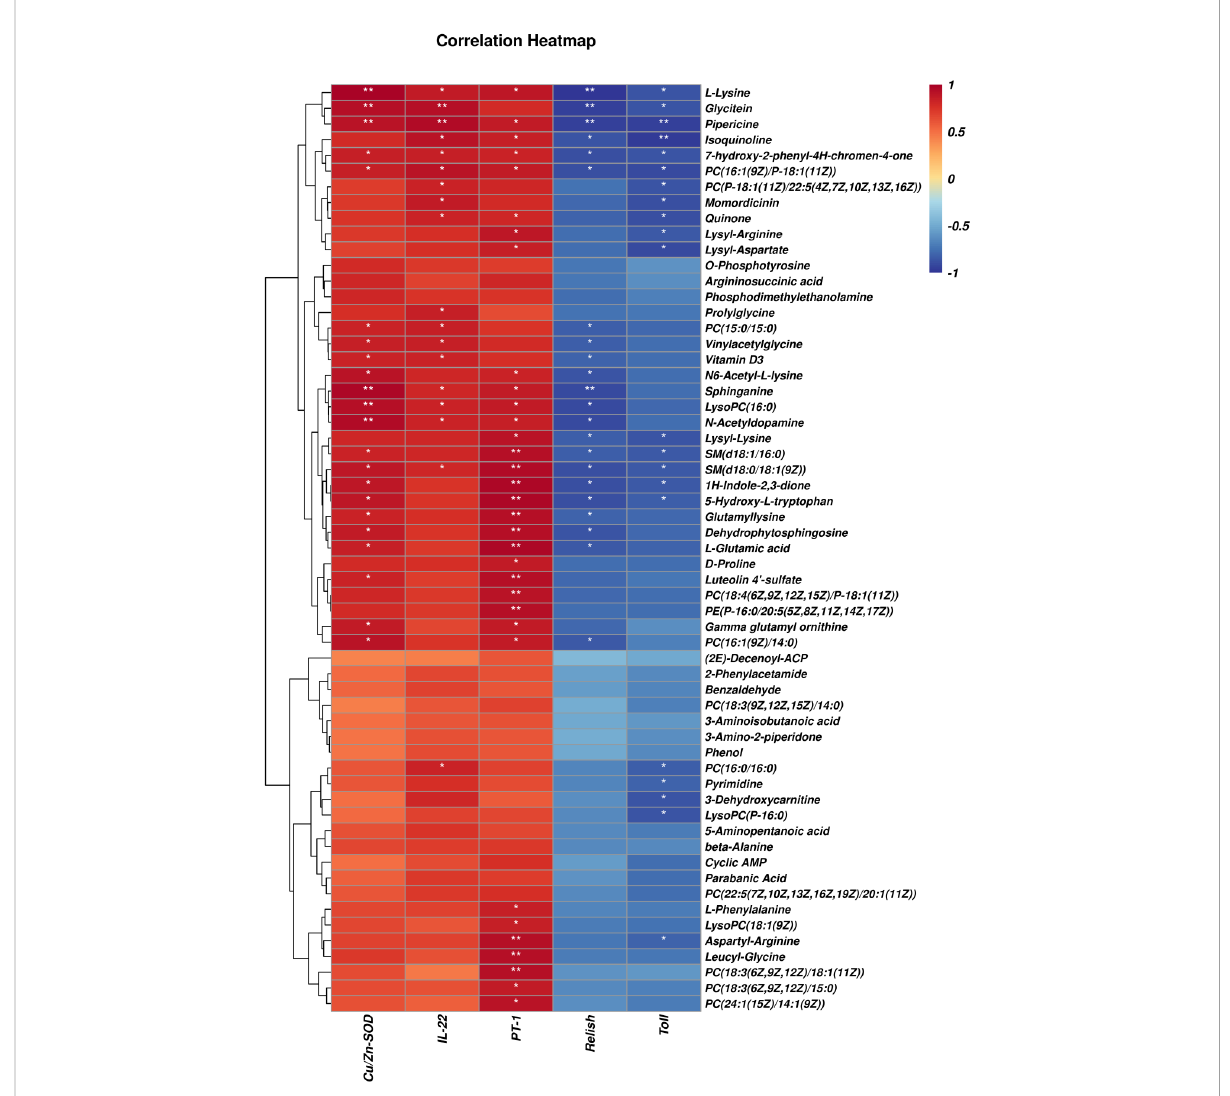
FIGURE 9 Correlation analysis of selected differential metabolites and intestinal genes between LF and BC groups. Red represents a positive correlation; blue represents a negative – positive correlation. The darker the color, the stronger the correlation. * p < 0.05, ** p <